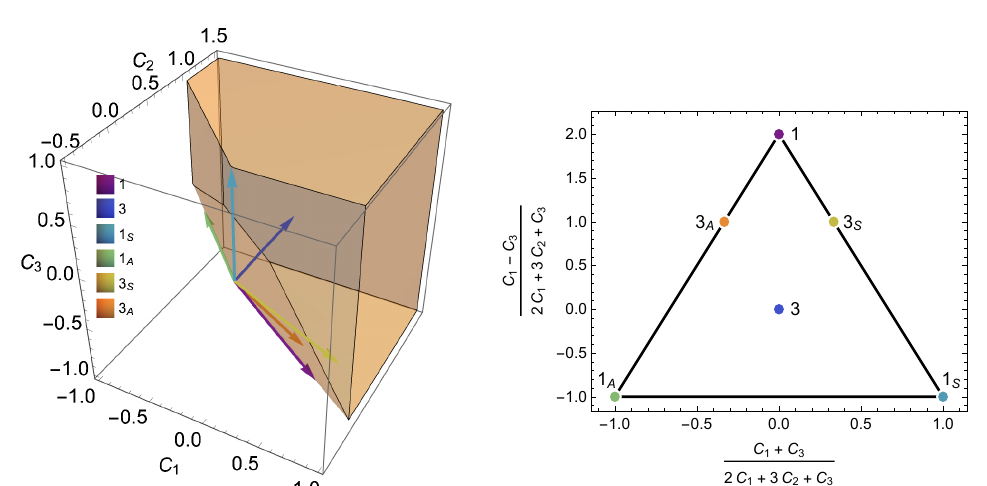
Figure 5. The positivity cone for 4-Higgs operators, with the corresponding generators. Colors represent different irreps. They are only labeled with SU(2) irrep (1 , 3) and the exchange symmetry (S,A). The cone is shown in the left plot, while the right plot shows a slice of the cone. The latter can be thought of as intersecting the cone with a hyperplane 2 C